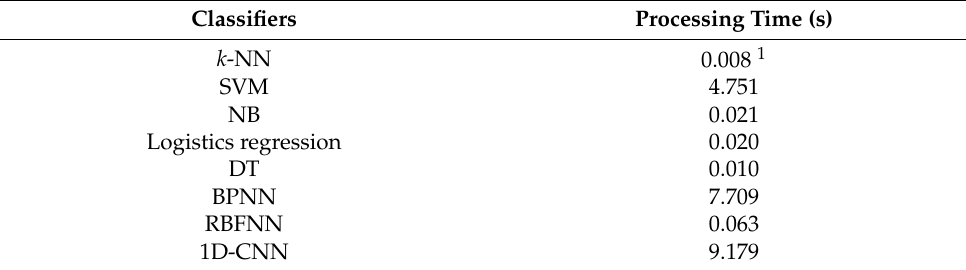
Table 5. Processing time of different classifiers for assessing motion accuracy.